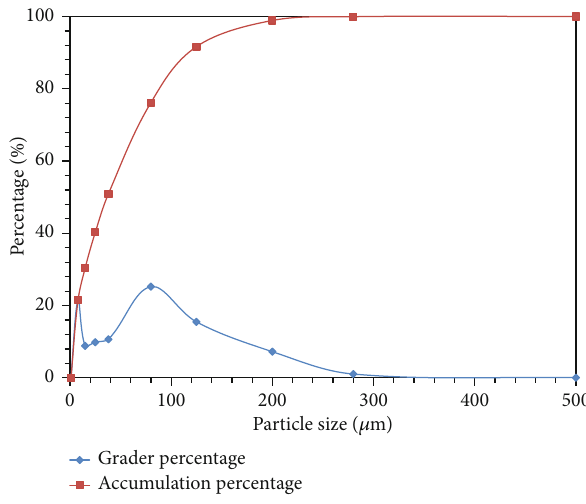
Figure 1: Particle size distribution curve of